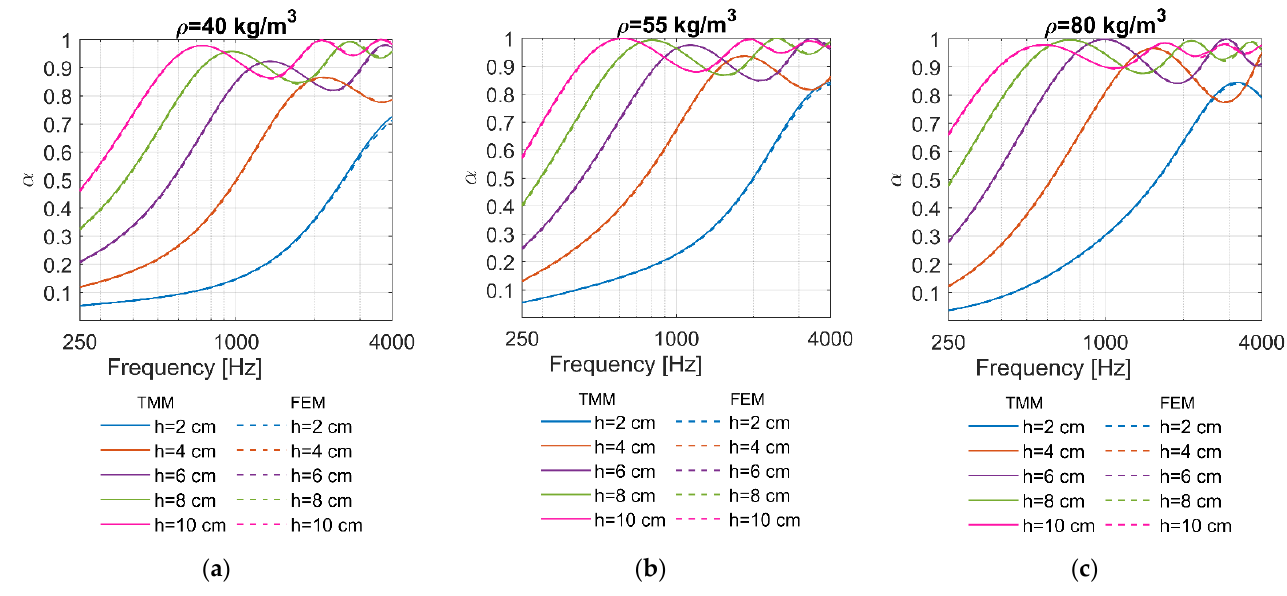
Figure 10. Calculated sound absorption coefficients for RPU foams with different thicknesses. Observing the samples with thicknesses of 6 and 8 cm, for the RPUF with density ρ = 40 kg/m 3 , the shift of the peak’s maximum was from 1355 to 960 Hz ( ∆ f = 395 Hz), i.e., from λ /h = 4.22 to λ /h = 4.47, where λ = 343/f is the acoustic wavelength. For RPUF with density ρ = 55 kg/m 3 , increasing the thickness from 6 to 8 cm moved the maximum of the peak from 1135 to 800 Hz ( ∆ f = 335 Hz), i.e., λ /h = 5.04 to λ /h = 5.36. For ρ = 80 kg/m 3 the shift was from 995 to 730 Hz ( ∆ f = 265 Hz), i.e., from λ /h = 5.75 to λ /h = 5.87. The coefficient λ /h for the considered RPUFs increased with increasing density and thickness and became higher than 4, i.e., the speed of sound in the porous material became lower than the speed of sound in air [17]. In addition, the shifting range decreased with increasing density. In order to estimate the frequency after which the sound absorption coefficient be- came larger than 0.8, f 0.8 , for a given thickness [m] and density [kg/m 3 ] of the RPUF, a polynomial surface model with x degree of 4 and y degree of 2 was fitted to the predicted data for a range of thicknesses h = 0.04–0.13 m and considered densities ρ = 40 kg/m 3 , ρ = 55 kg/m 3 , and ρ = 80 kg/m 3 . The root mean square error for the fitted polynomial surface was RMSE = 16.1. The results are graphically presented in Figure 11. The densities ρ = 50 kg/m 3 , ρ = 60 kg/m 3 , and ρ = 70 kg/m 3 are included. This graph can help to quickly estimate the starting frequency of good sound absorption for the considered RPUFs. After f 0.8 , the sound absorption coefficients ranged between 0.8 and 1 for all thicknesses, except for h = 4 cm where a slight drop below 0.8 occurred in a very limited frequency